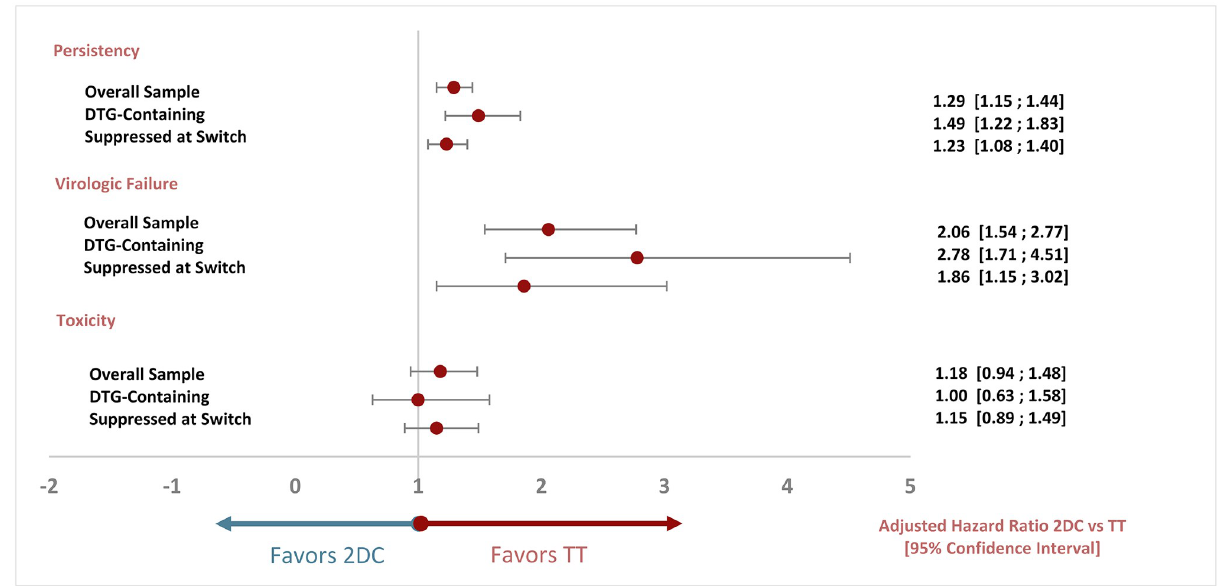
Fig 2. Adjusted hazard ratio for two-drug combinations versus triple therapy forest plot, by sample and endpoint. DTG: dolutegravir; 2DC: 2 drug combinations; TT: triple therapy.